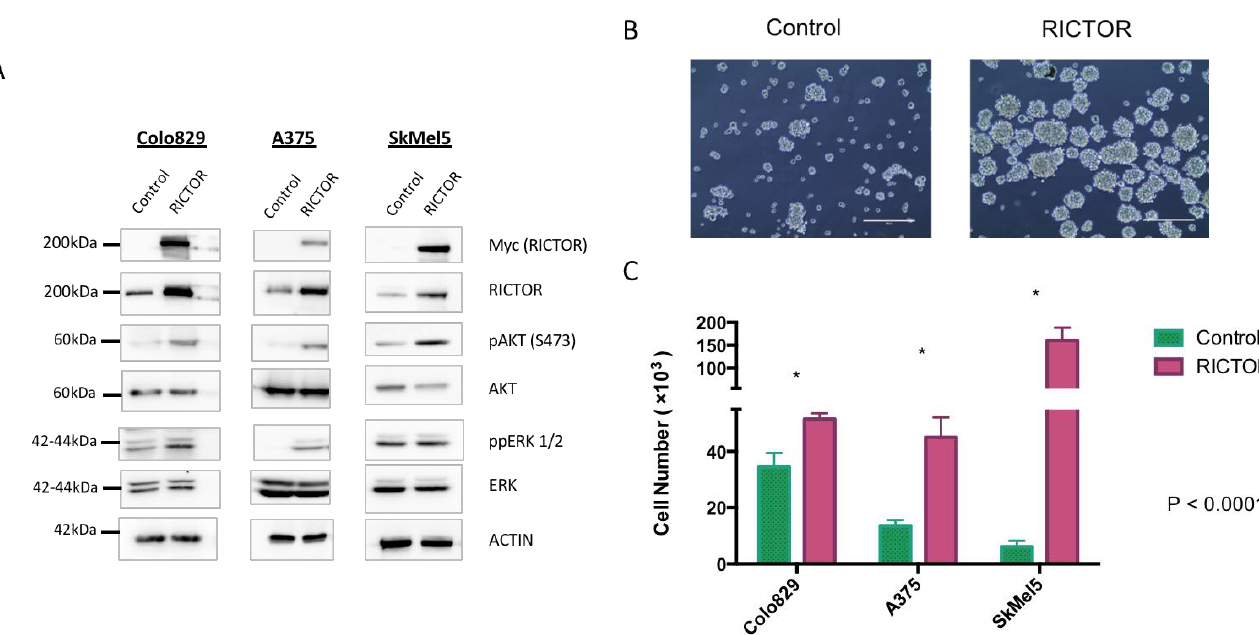
Figure 2. RICTOR overexpression promotes cell growth in spheroid culture ( A ) Colo829, A375, and SkMel5 melanoma cell lines were transfected with an empty vector (Control) or with a vector expressing human RICTOR cDNA (RICTOR). The expression of Myc-tag RICTOR, total RICTOR, phosphorylated AKT and ERK, and total AKT and ERK were assessed by Western blotting. ( B , C ) Colo829, A375, and SkMel5 cell lines transfected with an empty vector (Control) or with a vector expressing human RICTOR cDNA (RICTOR) were grown as a spheroid for 7 days and counted. Pictures from SkMel5 cell lines were taken after 7 days; scale bar represents 1000 μm. Graphs represent the mean ± s.d. of an experiment in triplicate (similar results were obtained in three independent experiments). Significance was calculated using the Student’s t -test: * p < 0.05.